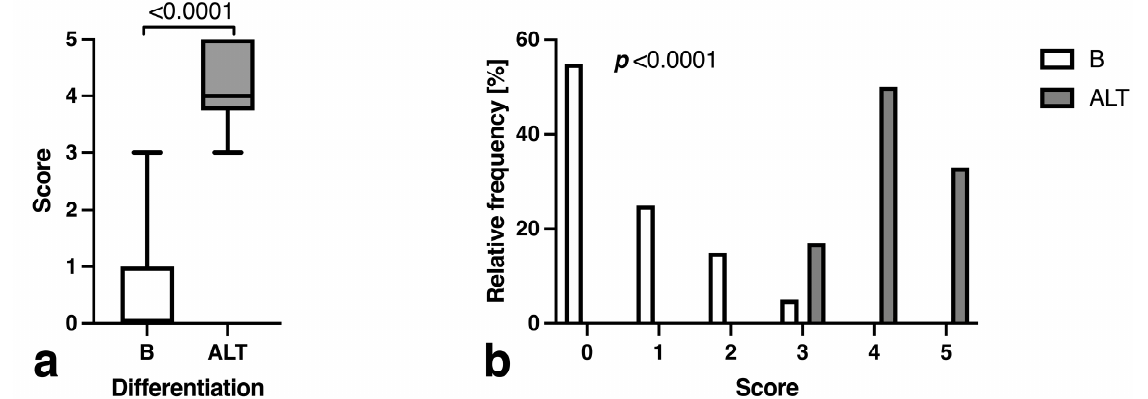
Figure 7. Comparison of ( a ) average score based on tumor volume, sphericity, maximum septation thickness, intra-tumoral without peritumoral STIR signal, presence of contrast enhancement and ADC signal alterations and ( b ) distribution of cases with benign or atypical differentiation by their score.